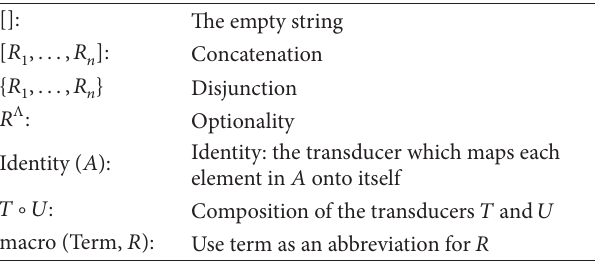
Table 4: A fragment of FSA regular expression syntax and 𝑈 transducers, and 𝑅 can be either.